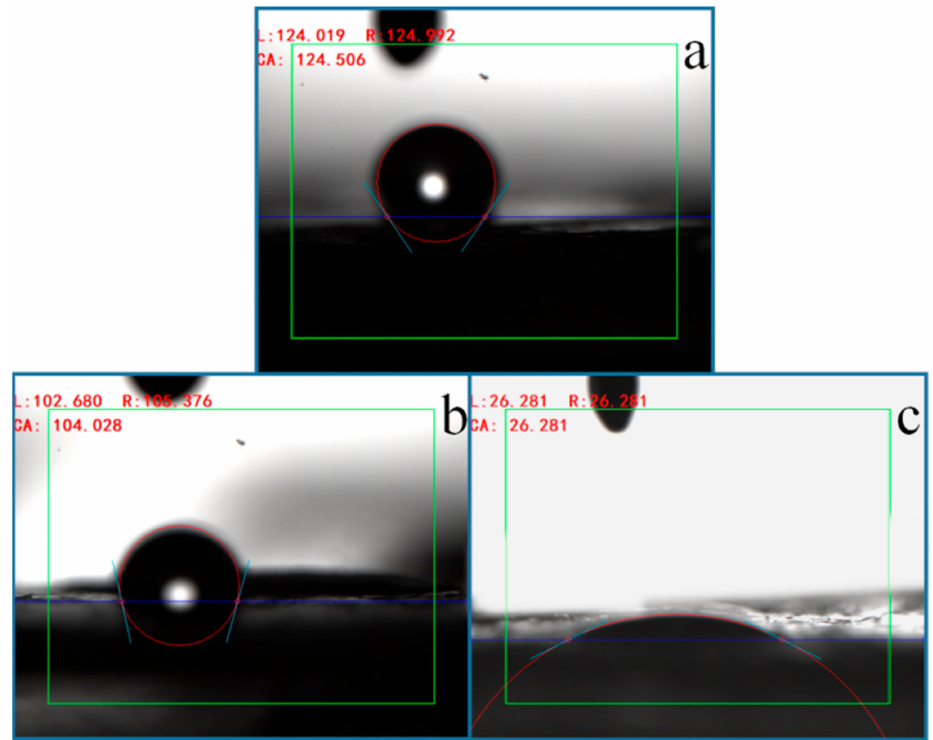
Figure 4. Contact angles of ( a ) raw mica, ( b ) mica ground at room temperature, and ( c ) mica ground at 200 ◦